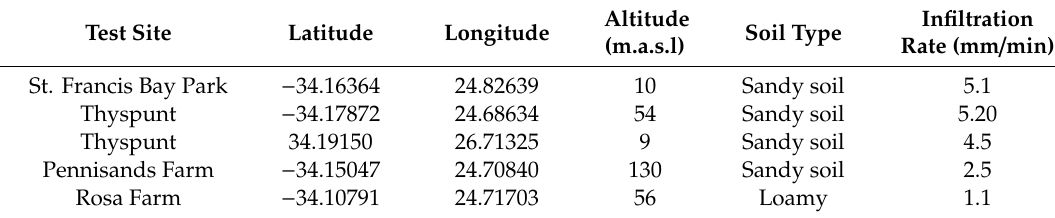
Table 2. Infiltration test results conducted around Thyspunt.